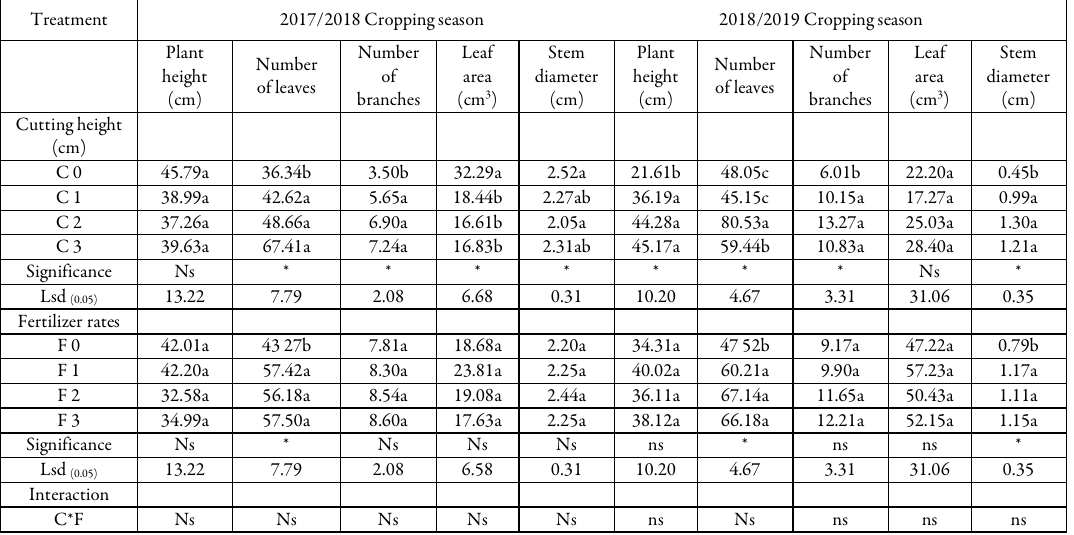
Table 2. Effect of cutting height and fertilizer application on some vegetative characters of Amaranthus cruentus L . Treatment